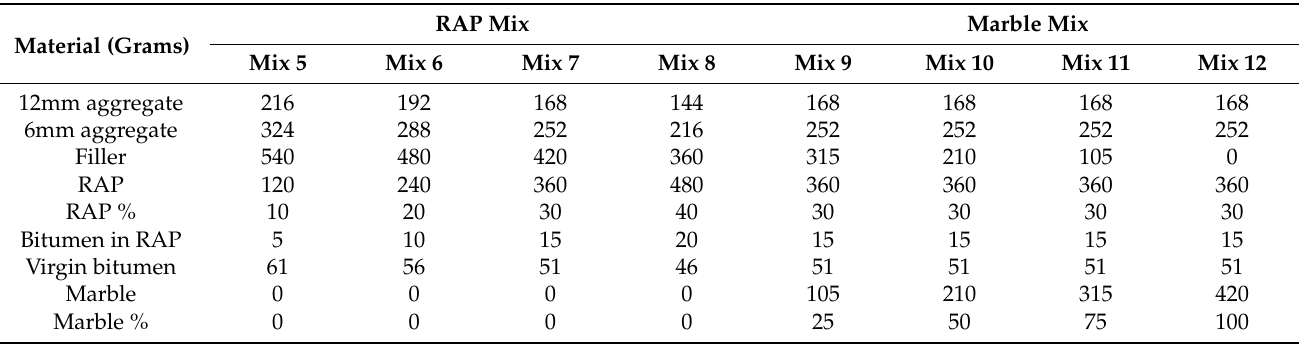
Table 5. Sustainable Mix Proportion.